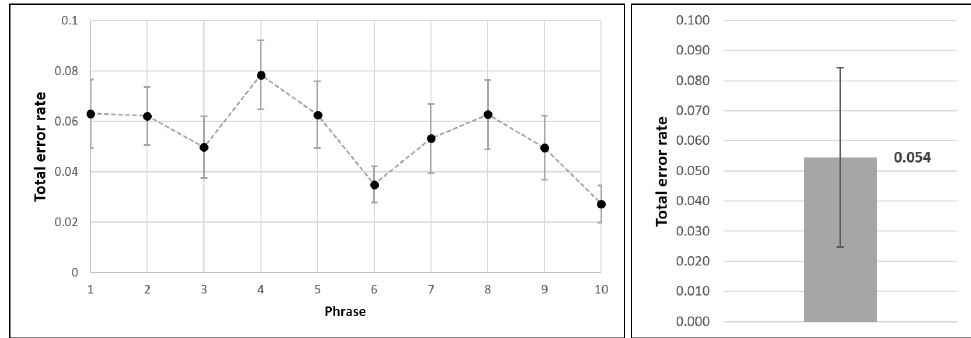
Figure 12. Total error rate obtained within the empirical evaluation of magnet-based text en- try method.